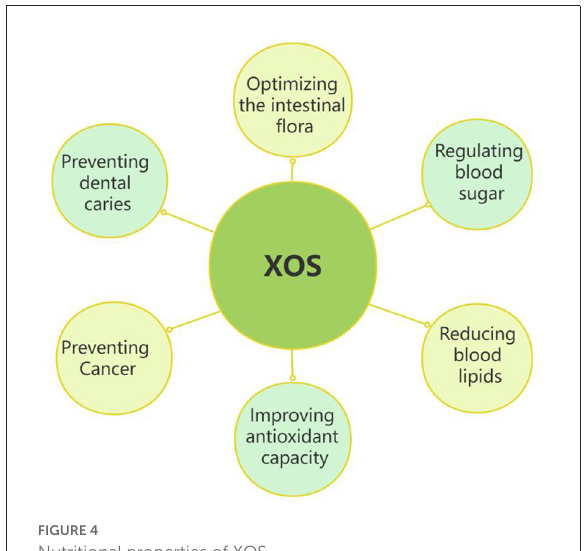
FIGURE4 Nutritional properties of